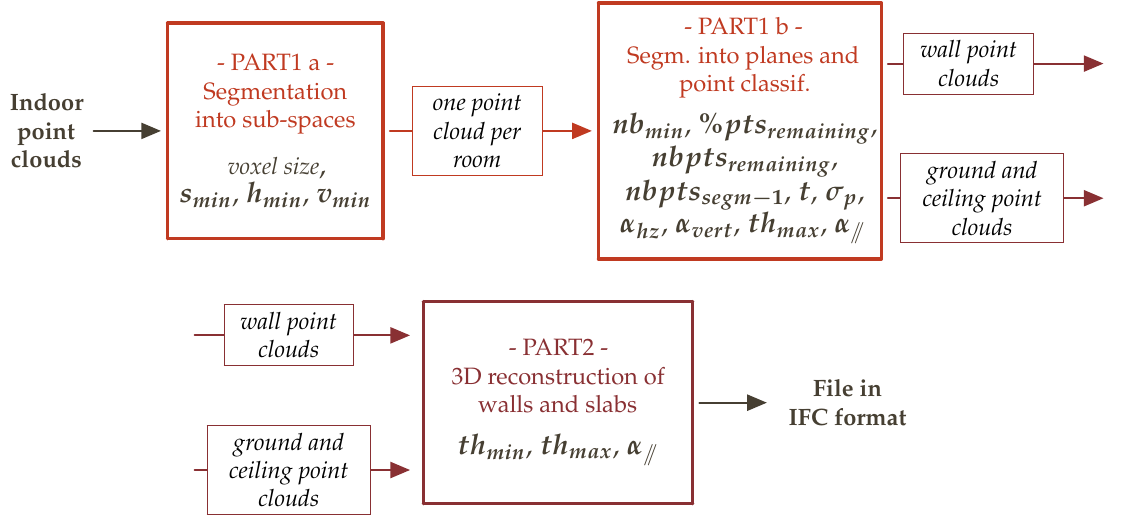
Figure 12. Steps of the developed approach and associated